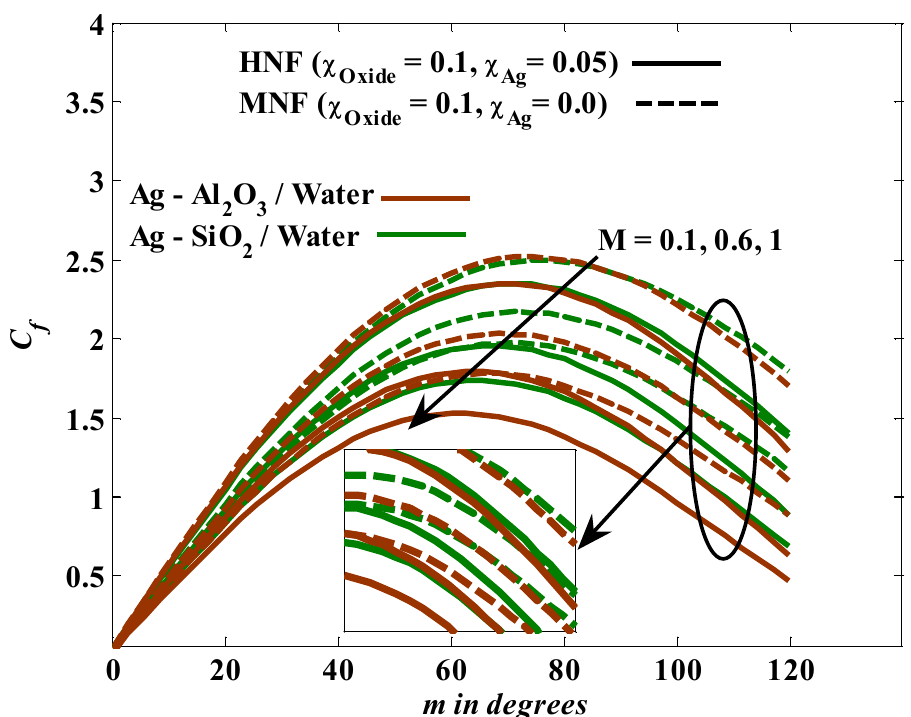
Figure 9. Illustration of M versus skin friction at fixed values of We = 0.2, R = 0.1, & λ = 1.